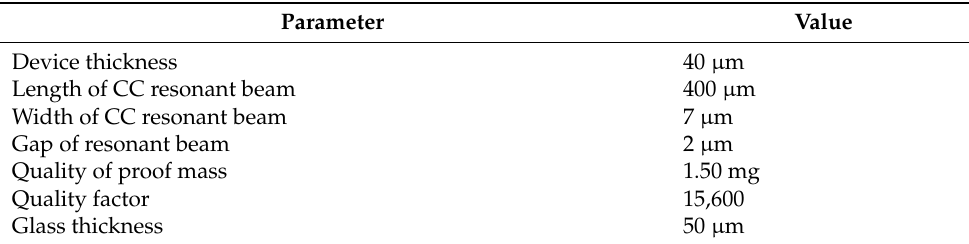
Figure 2. The schematic of the mode localized accelerometer. The geometrical dimensions of the DETF-CC WCRs mode localized accelerometer are summarized in Table 1. Table 1. Parameters of the